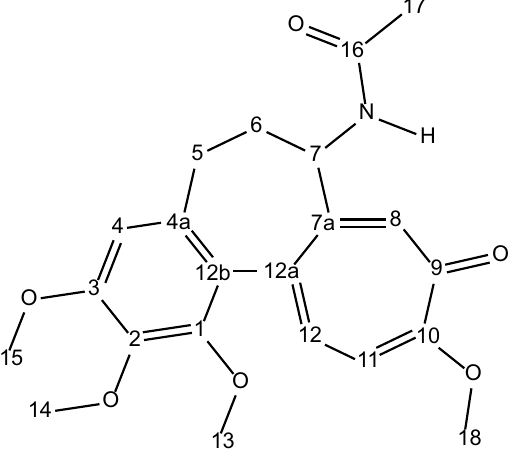
Figure 1. The numbering system used for colchicine ( 1 ) molecule for NMR